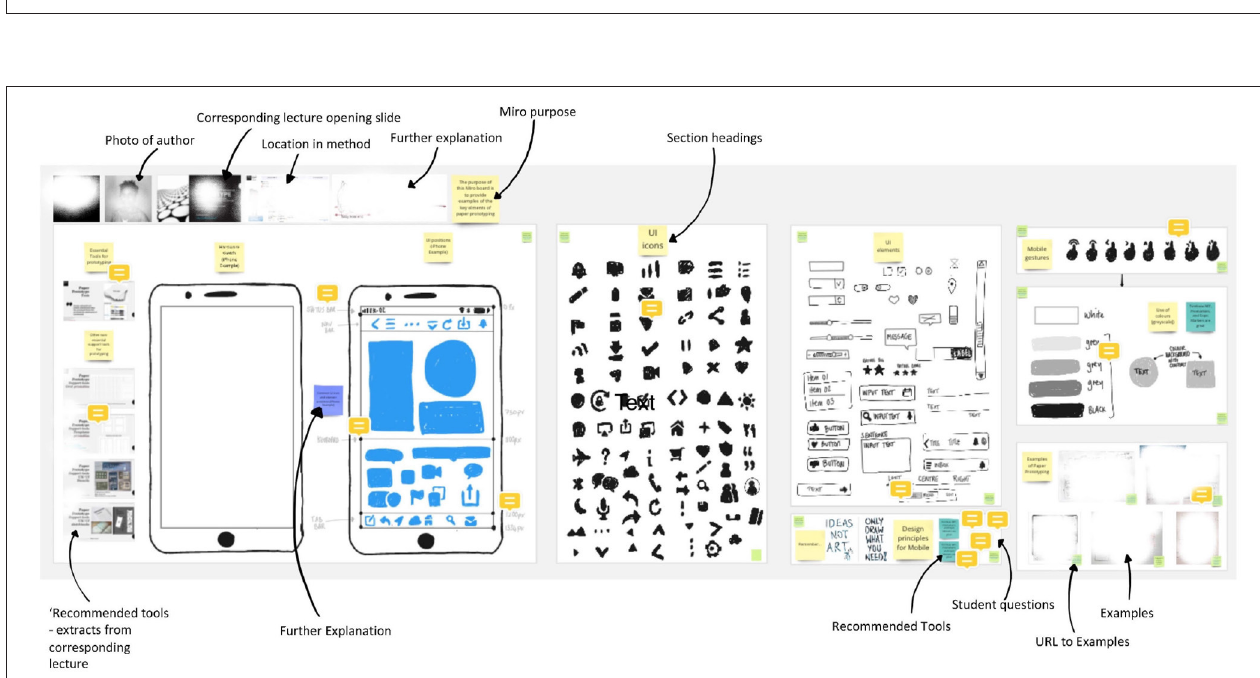
FIGURE 9 | Example interactive Miro board for demonstration of sketching components and icons for low-fidelity paper prototyping lecture. Makayla Lewis, 2021.